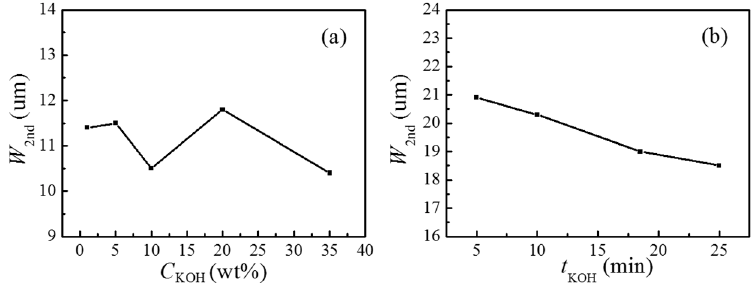
Figure 4. ( a ) Width of the second layer walls ( W 2nd ) varies with KOH concentration( C KOH ). ( b ) Width of the second layer walls ( W 2nd ) changes with etching time in KOH solution ( t KOH ). The sample patterns are 50 μ m × 50 μ m square with gap distance of 5 μ m. Each data point was obtained by averaging the values from three samples. All samples were etched in HF solution for 1.5 min. The etching time and temperature was 30 min and 70 °C for ( a ). The KOH concentration was 10 wt % KOH and etching temperature was 70 °C for ( b ).